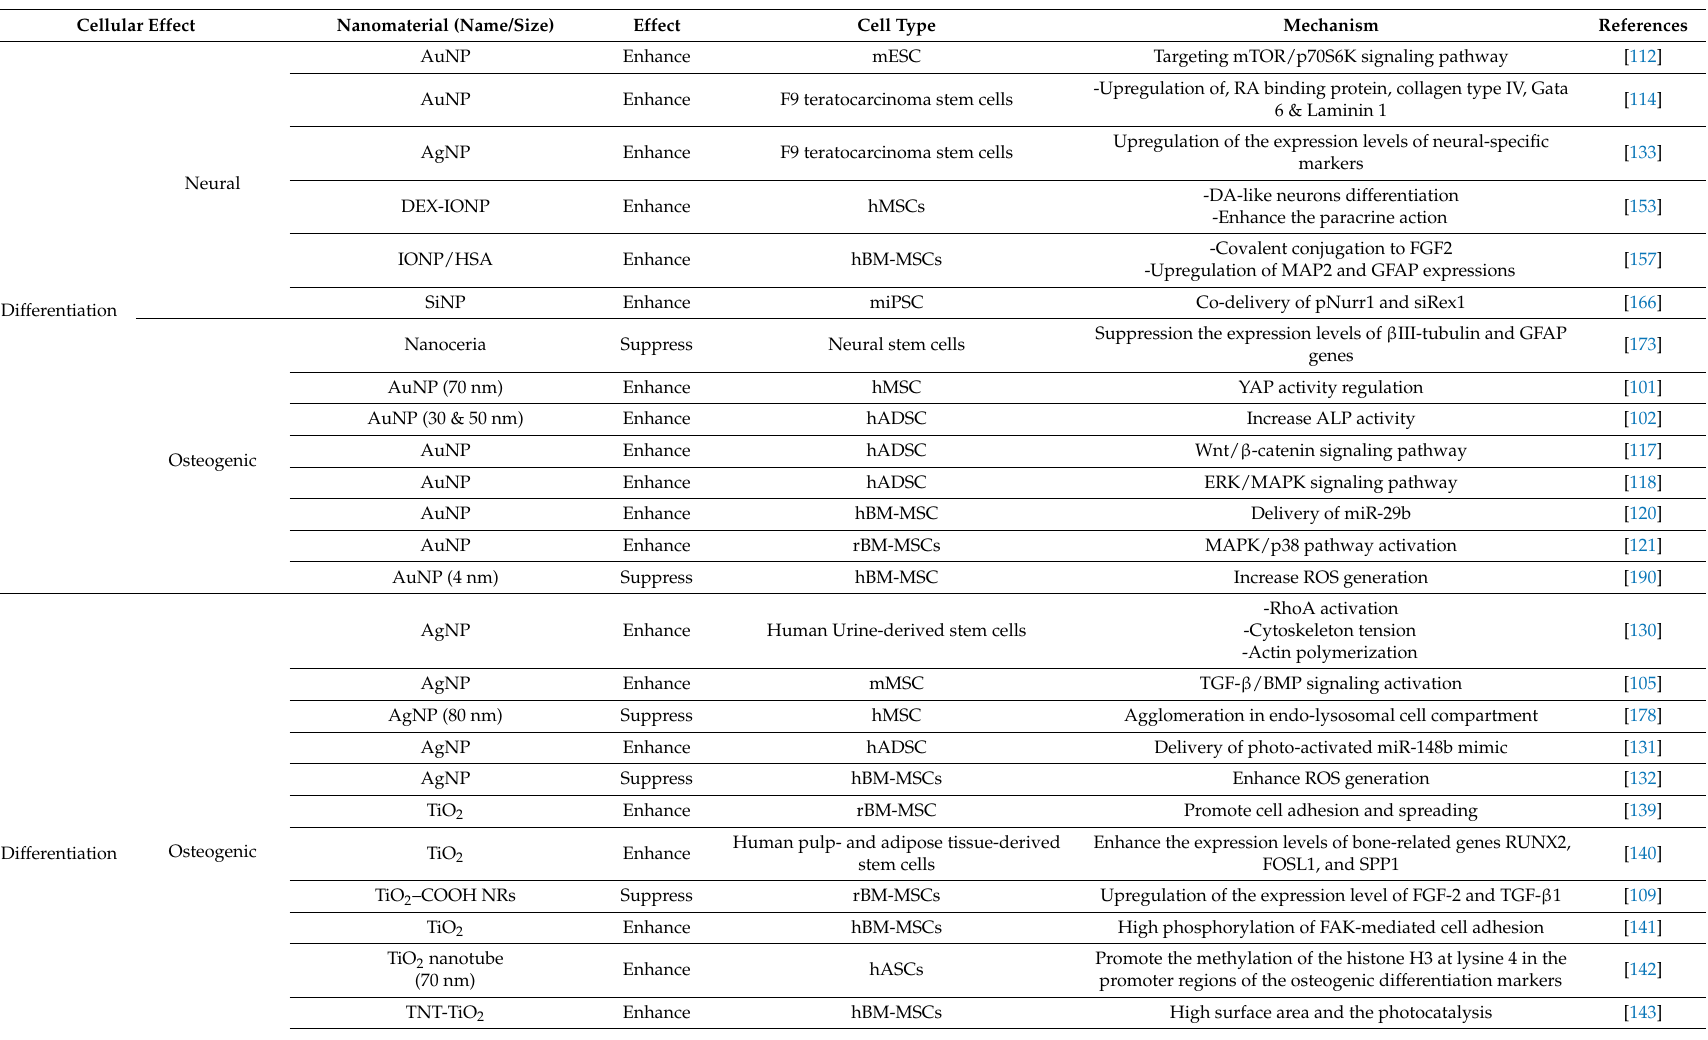
Table 1. The effects of metallic NPs on stem cell differentiation, proliferation and